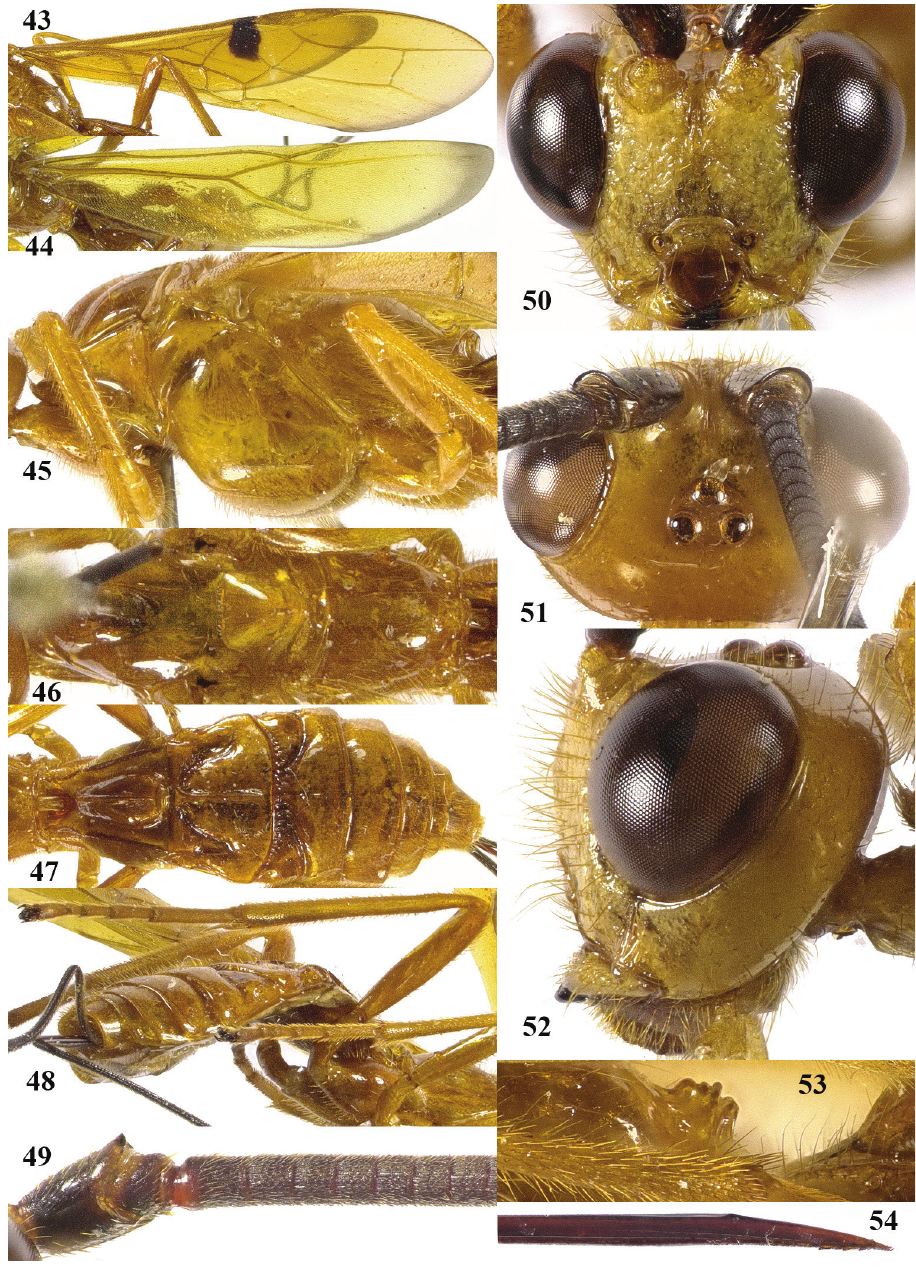
Figures 43–54. Maculibracon abruptus sp. n., ♀ , holotype. 43 fore wing 44 hind wing 45 mesosoma lateral 46 mesosoma dorsal 47 metasoma dorsal 48 hind leg lateral 49 scapus outer side lateral 50 head anterior 51 head dorsal 52 head lateral 53 propodeum lateral 54 apex of ovipositor